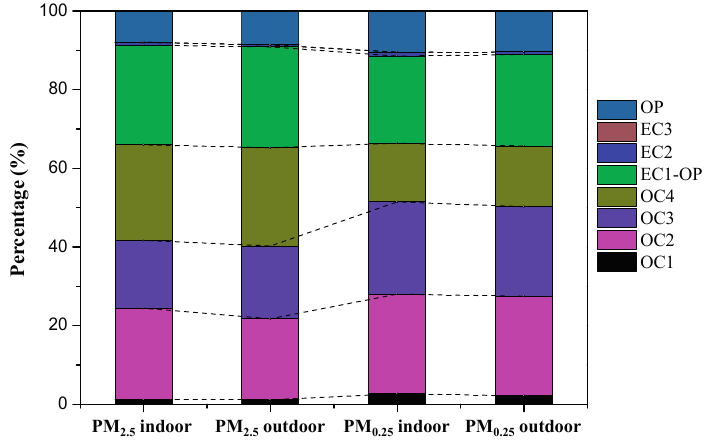
Figure 6. Percentage variations of OC and EC eight fractions in PM 2.5 and PM 0.25 inside the classroom and